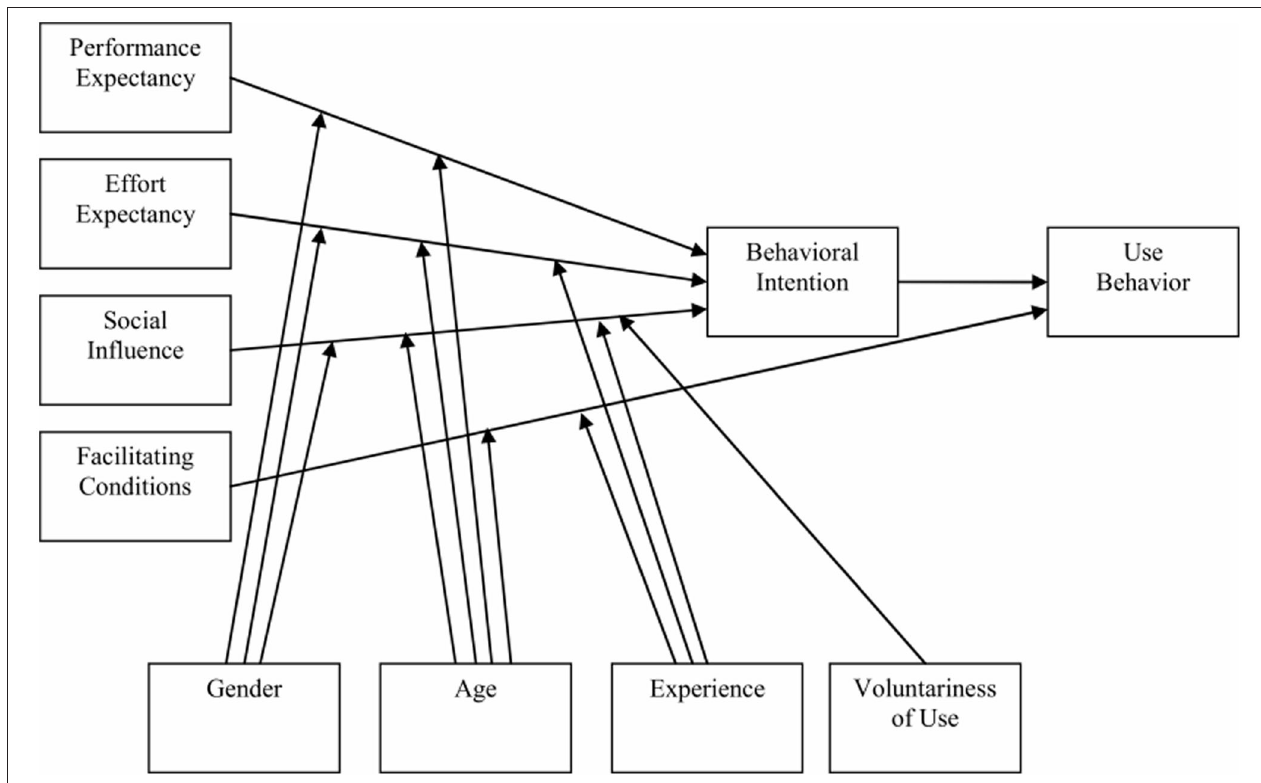
FIGURE 1 | The unified theory of acceptance and use of